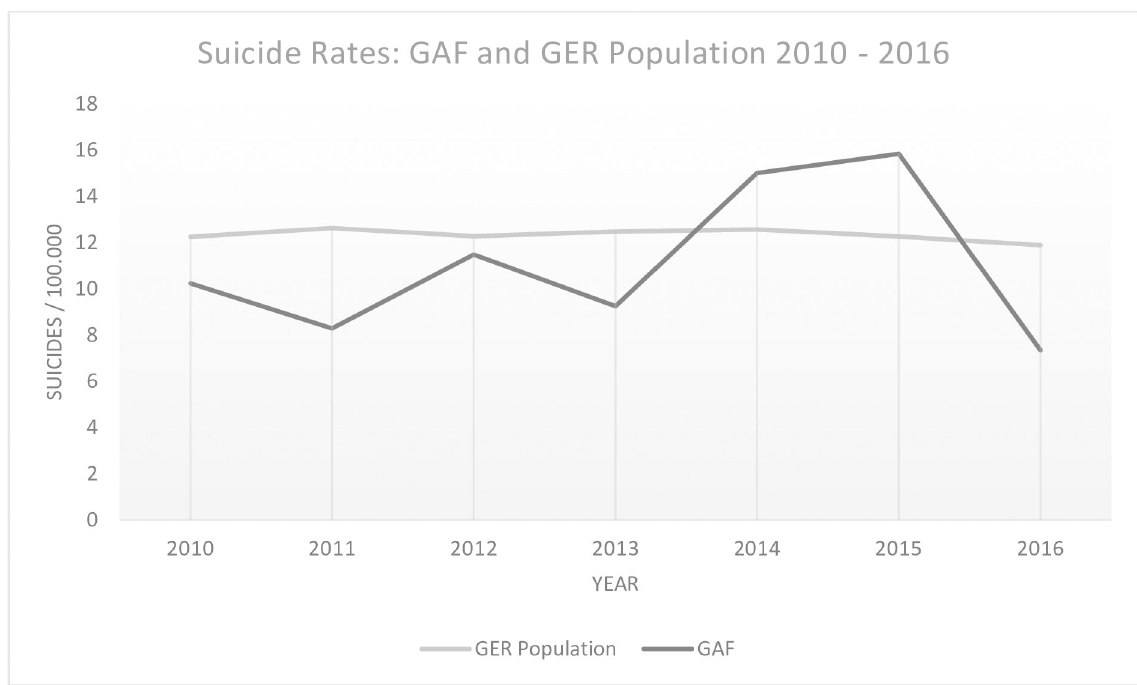
Fig 1. Suicide rates per 100.000 individuals of German Armed Forces/Bundeswehr (GAF) and German population (GER population) 2010–2016.